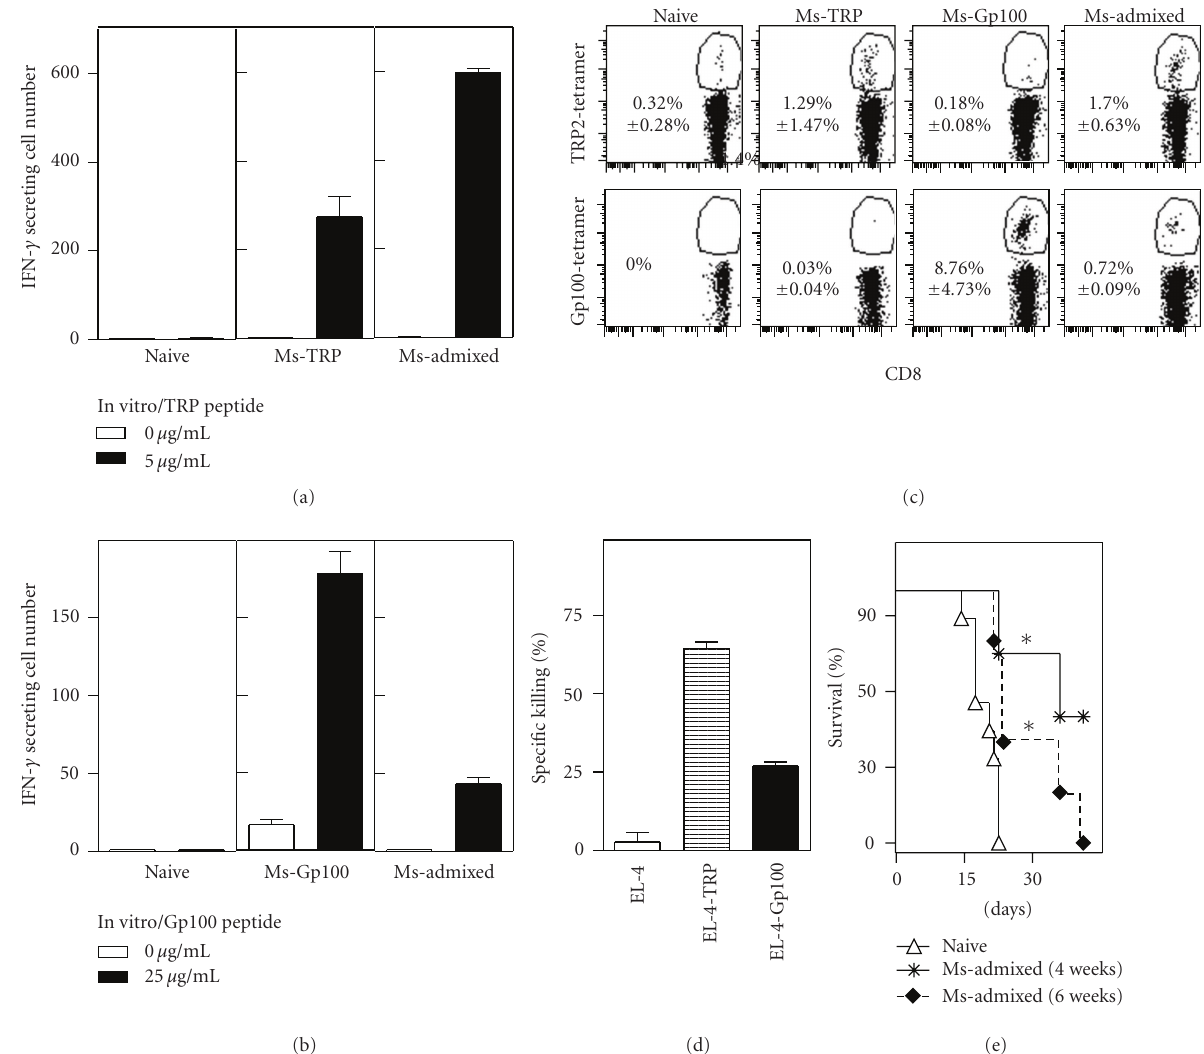
Figure 6: Optimized induction of CD8 + T cell response to dual melanoma antigen vaccine. Mice were vaccinated (days 0 and 21) with 30 μ g of individual peptide-archaeosome vaccines or in an admixed formulation containing 30 μ g of each peptide. At 4 weeks, representative mice ( n = 3 per group) were euthanized, the spleen cells were stimulated with IL-2 (0.1ng/mL) and each peptide (5–25 μ g/mL) for 48 h, and the frequency of IFN-gamma secreting cells was enumerated by ELISPOT. Mean ± SD ( n = 3) of IFN-gamma secreting cells per 10 6 spleen cells is indicated for TRP-peptide (a) and Gp100 peptide (b) stimulation. The percentage of tetramer-specific CD8 + T cells was enumerated in the blood on day 28. Representative plots for the various groups are shown (c), and the Mean ± SD ( n = 3) of the response is indicated within each panel. In vitro CTL response in representative mice ( n = 3/group) vaccinated with the admixed formulation was evaluated on day 28 against EL-4, EL-4-TRP, and EL-4-Gp100 targets (d). Mean ± SD at 100 :1 e ff ector: target ratio is indicated. At 4 or 6 weeks postvaccination, mice ( n = 5 per group) were challenged with B16 melanoma (e). Survival curves for the vaccinated groups were significantly di ff erent from na¨ıve by log-rank test ( P < . 05). Archaeosome loadings were 40 μ g Gp100/mg and 20 μ g TRP/mg lipid. Archaeosome size ranged from 110 to